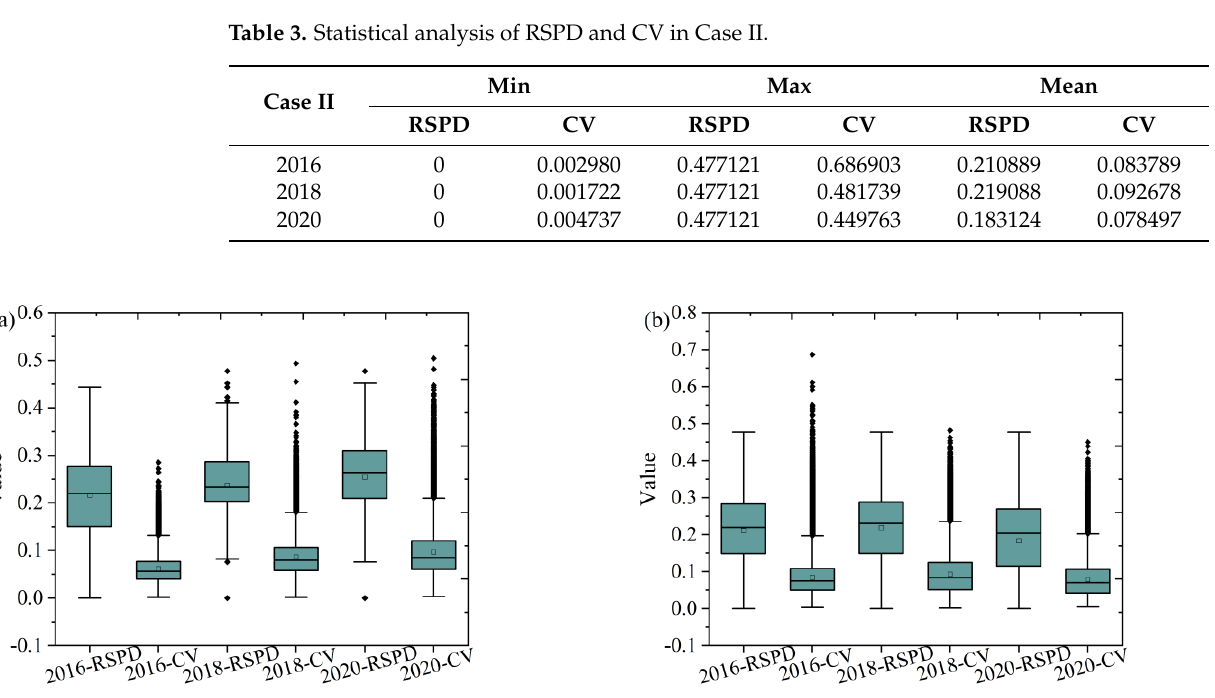
Figure 4. The temporal change trend of RSPD and CV, where ( a ) is the result of Case I study area and ( b ) is the result of Case II study area.